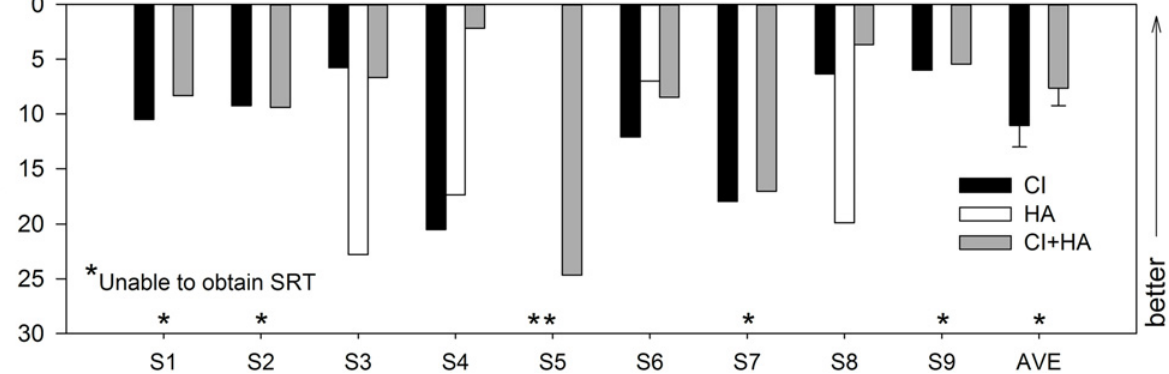
Fig 4. Speech-in-noise results for individual subjects across hearing devices. CI-only SRTs are shown by the black bars, HA-only SRTs are shown by the white bars, and CI+HA SRTs are shown by the gray bars. Mean performance is shown at the far right; error bars indicate standard error. Asterisks indicate that SRTs could not be measured for that condition. Bars closer to the top of the graph indicate better